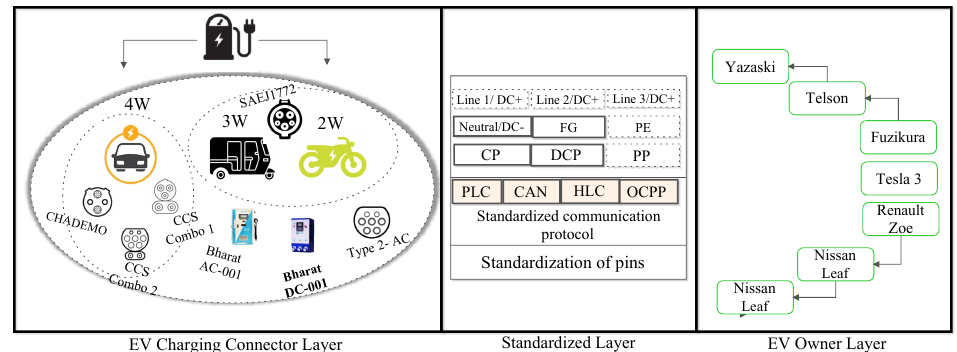
Figure 9. The proposed EV charging station standardization